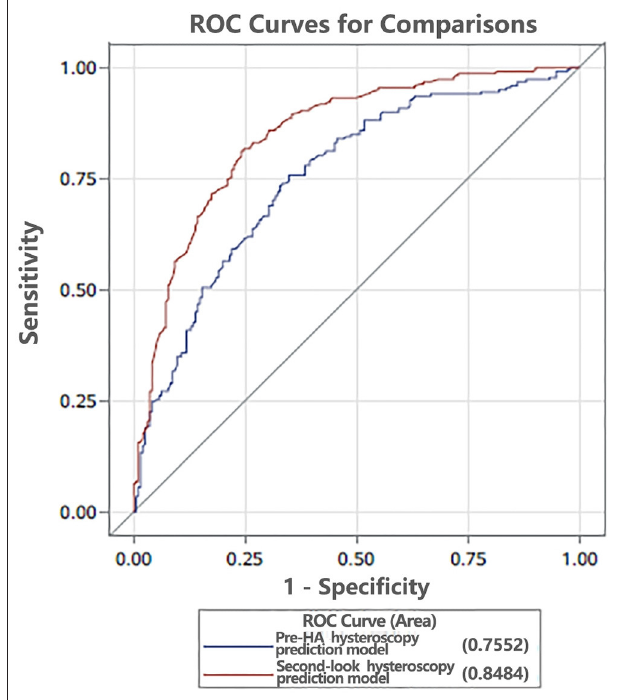
FIGURE 1 | The areas under the curves (AUCs) of the pre-HA and second-look hysteroscopy prediction models were 0.7552 and 0.8484, respectively. HA, hysteroscopic